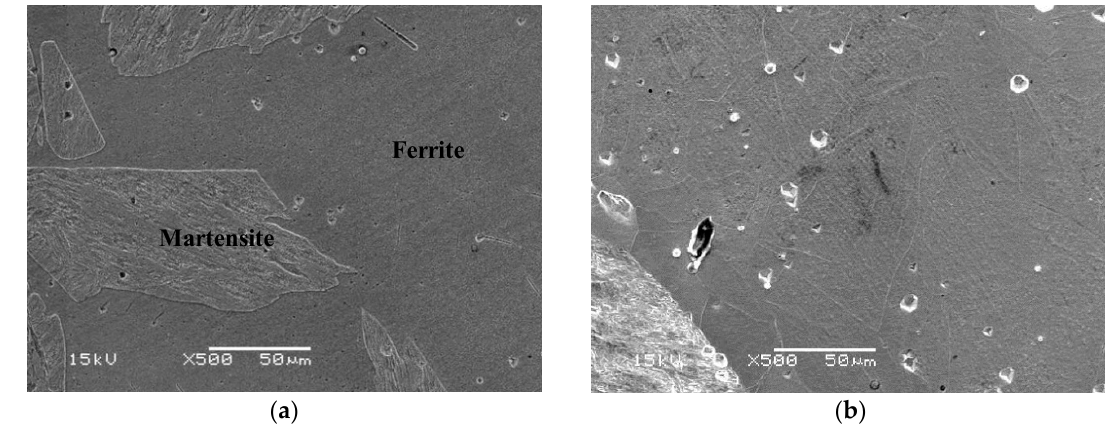
Figure 2. ( a ) SEM image of the as ‐ quenched specimen; ( b ) revealing that the microstructure of the alloy was a ferrite matrix with 30% martensite phase.